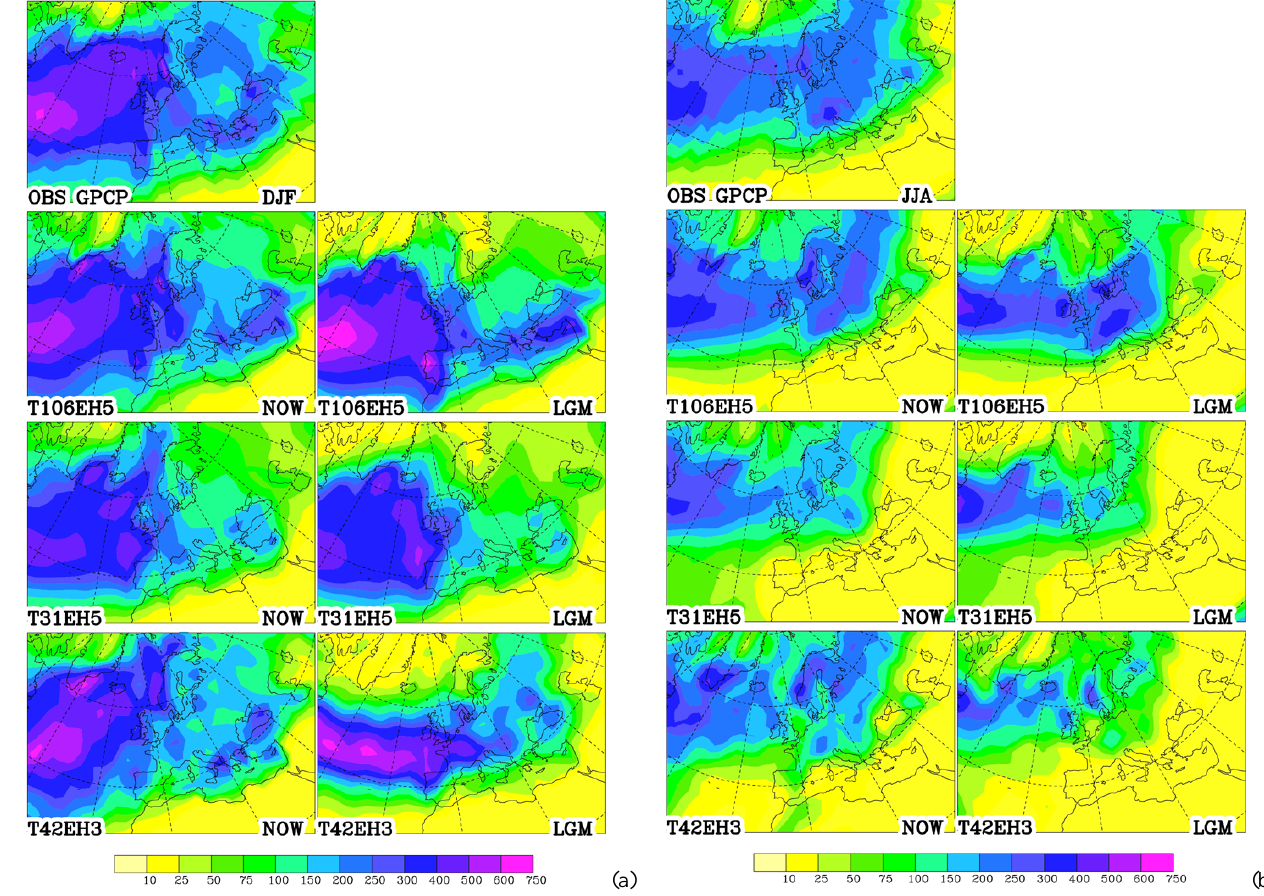
Fig. 5. Precipitation as estimated for the truth (GPCP; Huffman et al., 1996) and simulated by the models. Contours at 10, 25, 50, 75, 100, 150, 200, 250, 300, 400, 500, 600mmseason − 1 , (a) for winter, (b) for